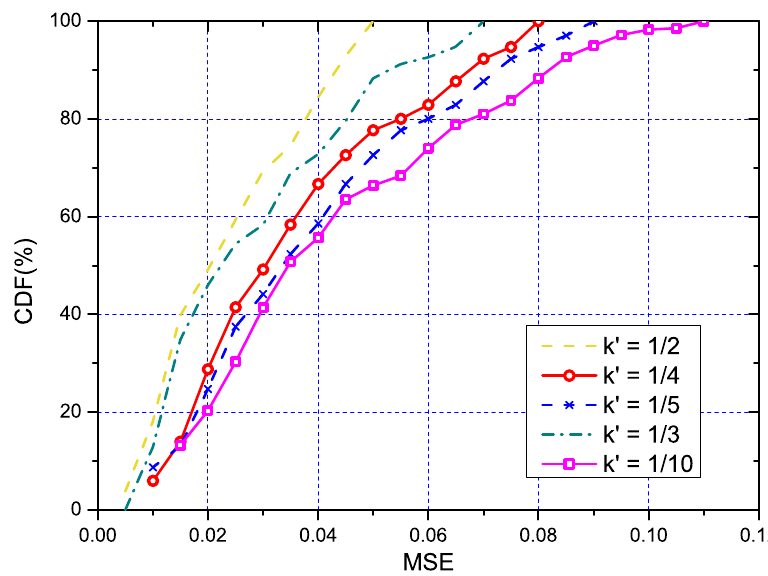
Figure 7. The CDF of estimated MPE under different numbers of representative links.